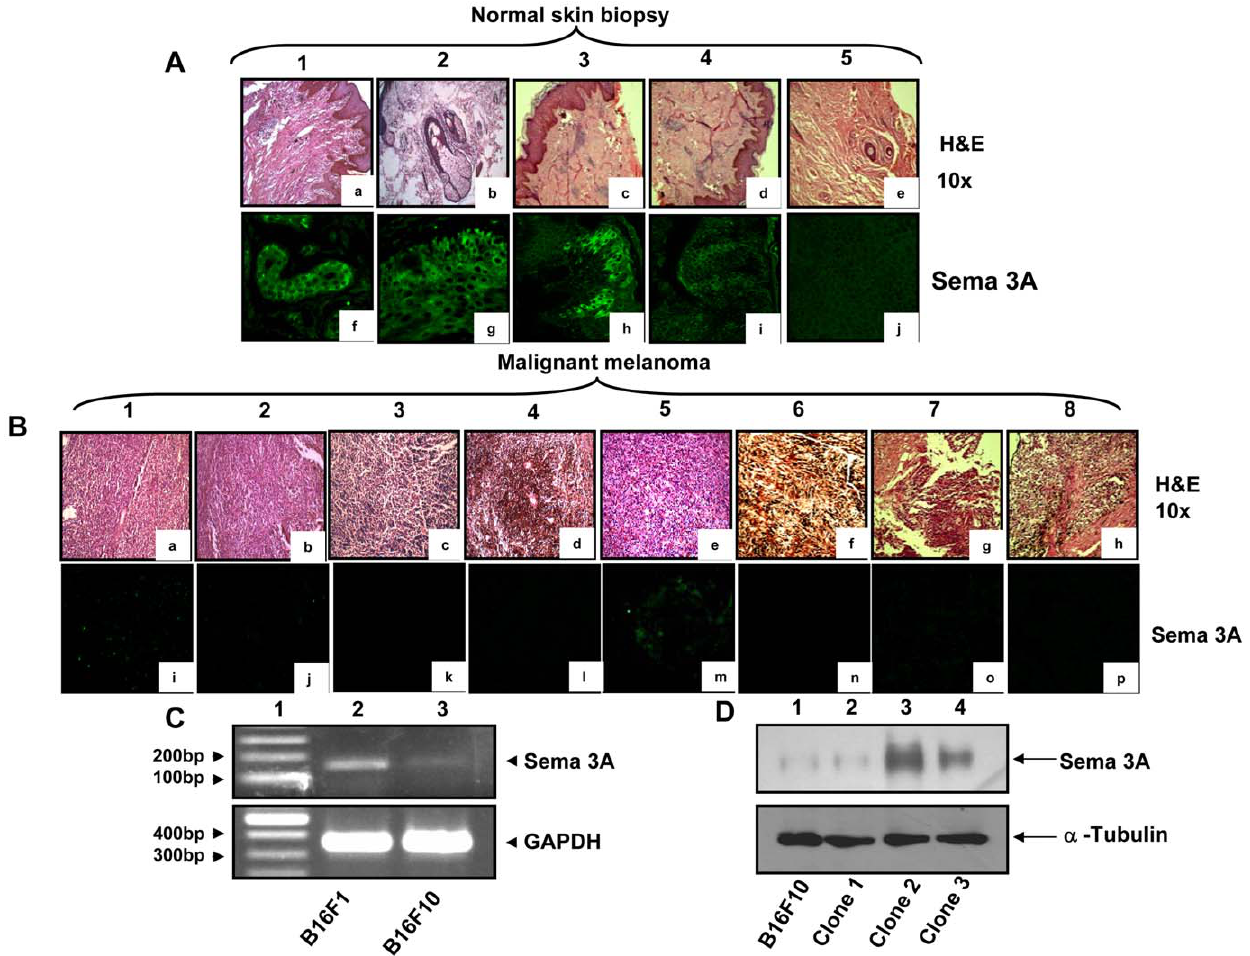
Figure 1. Histopathological and immunohistochemical analyses of human normal skin biopsy and malignant melanoma tissues. ( A&B ) Five normal skin biopsy and eight malignant melanoma specimens were stained with hematoxylin and eosine and the histopathologic micrographs were visualized at 10 6 magnifications (Fig. 1A, panels a–e, & Fig. 1B, panels a–h). Tissue sections were also analyzed immunohistochemially for visualizing the expression of Sema 3A (Fig. 1A, panels f–j & Fig. 1B, panels i–p). Sema 3A was stained with Cy2 (Green). Note that significant loss of Sema 3A expression was detected in malignant melanoma tissue samples as compared to normal skin samples. ( C ) Endogenous expression of Sema 3A mRNA in B16F1 and B16F10 cells as detected by RT-PCR. GAPDH was used as loading control. ( D ) Expression of Sema 3A in B16F10 clones were analyzed by Western blot using specific antibody. The second clone (lane 3, denoted as clone 2) shows significantly higher expression of Sema 3A as compared to other clones and control B16F10 cells. The data represent three independent experiments exhibiting similar results.